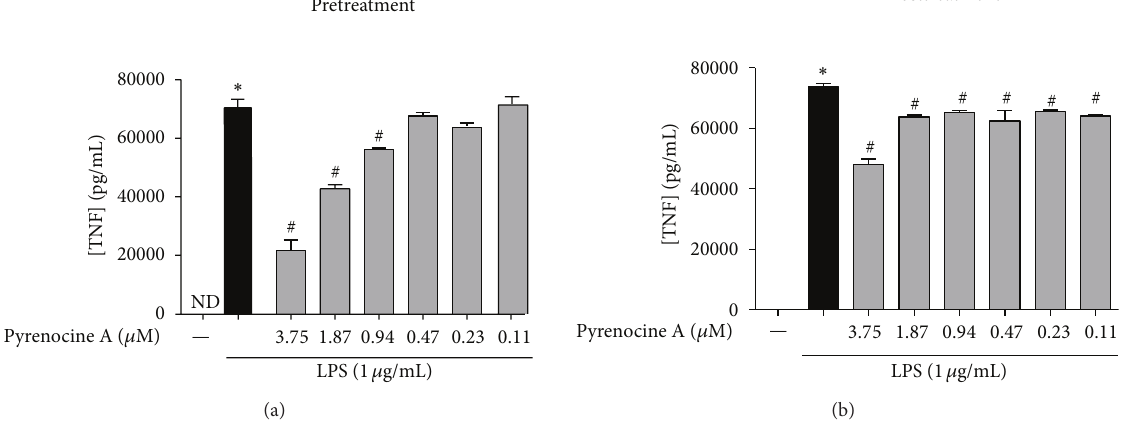
Figure 3: Anti-inflammatory effects of pyrenocine A on the production of TNF- 𝛼 . (a) Pretreatment procedure: cells were pretreated with different concentrations of pyrenocine A (3.75–0.11 𝜇 M) for 2 h and then stimulated with LPS (1 𝜇 g/mL) during 18h. (b) Posttreatment procedure: cells were stimulated with LPS (1 𝜇 g/mL) for 2 h and then pyrenocine A (3.75–0.11 𝜇 M) was added during 18h. The supernatants were collected, and cytokine quantification was performed using an ELISA system. Results correspond to the mean ± SEM of six independent experiments performed in quadruplicate for each condition. ∗ 𝑃 < 0.05 versus medium (control), # 𝑃 < 0.05 versus LPS (ANOVA followed by Bonferroni). ND = not